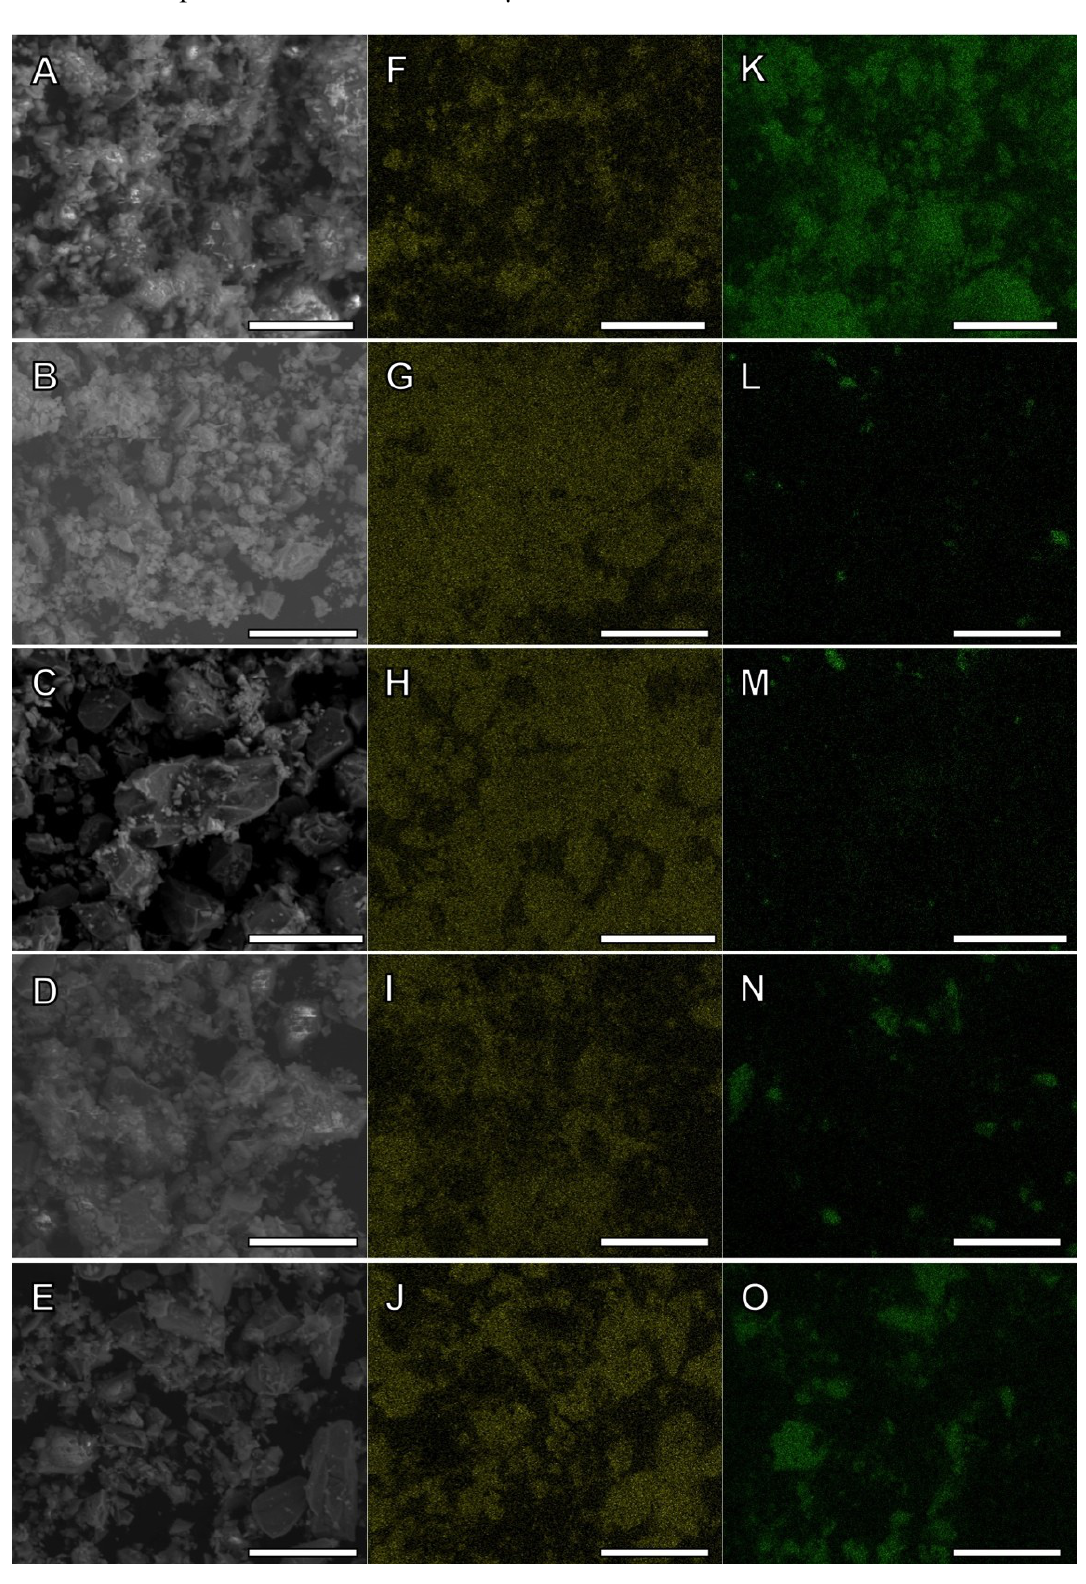
Figure 3. Scanning electron micrographs [panels ( A )–( E )] and energy dispersive X-ray spectroscopy (EDS)-based maps of Fe [panels ( F )–( J )] and Si [panels ( K )–( O )] of BIF [panels ( A ), ( F ) and ( K )], canga [( B ), ( G ) and ( L )], iron ore [panels ( C ), ( H ) and ( M )], HEM [panels ( D ), ( I ) and ( N )], and HEM [panels ( E ), ( J ) and ( O )] used for spec lam bioreduction experiments. Scale bars = 40